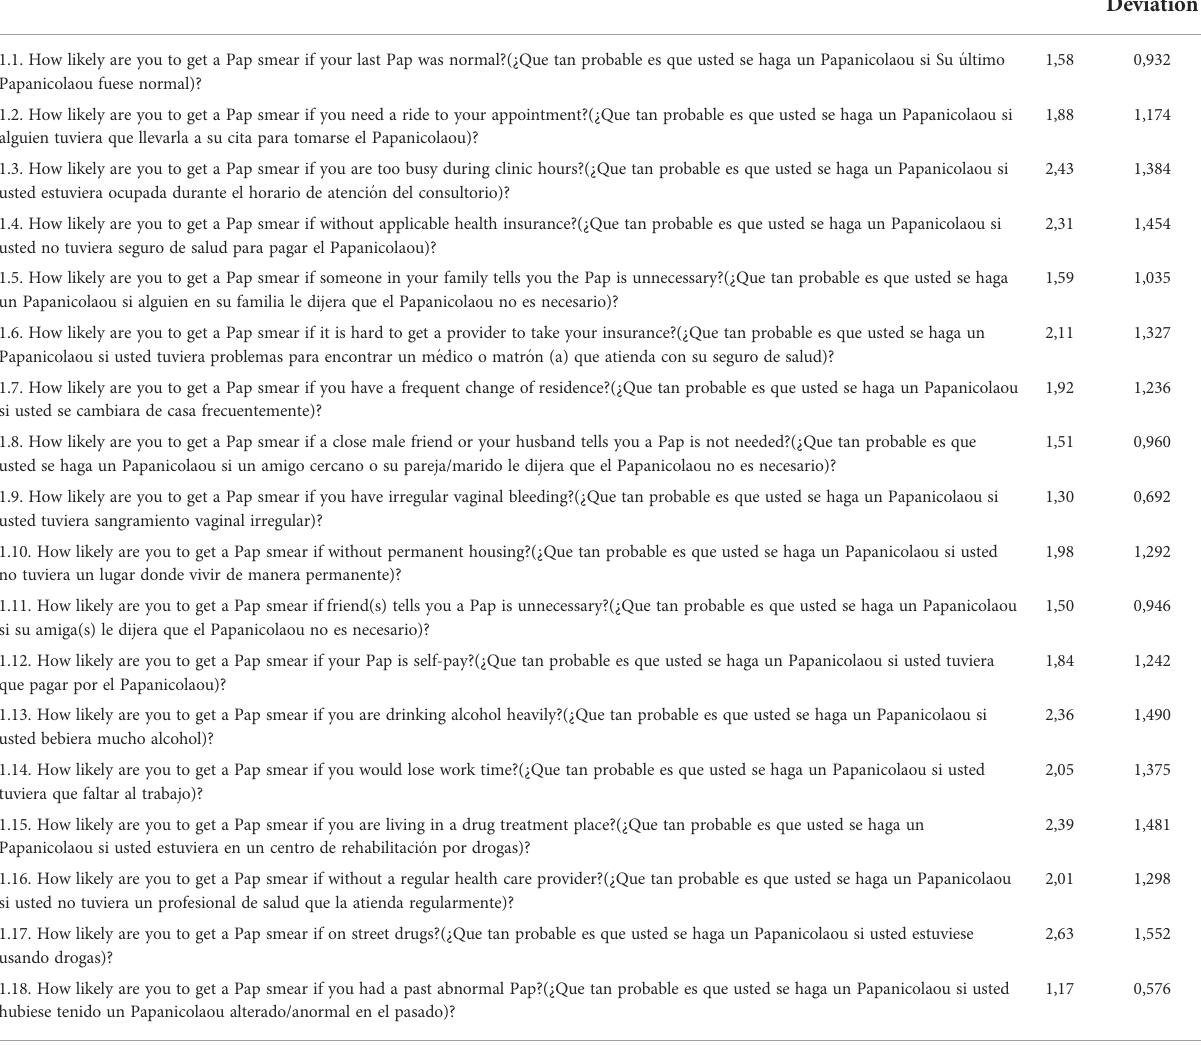
TABLE 1 Means and standard deviations of items of the questionnaire.